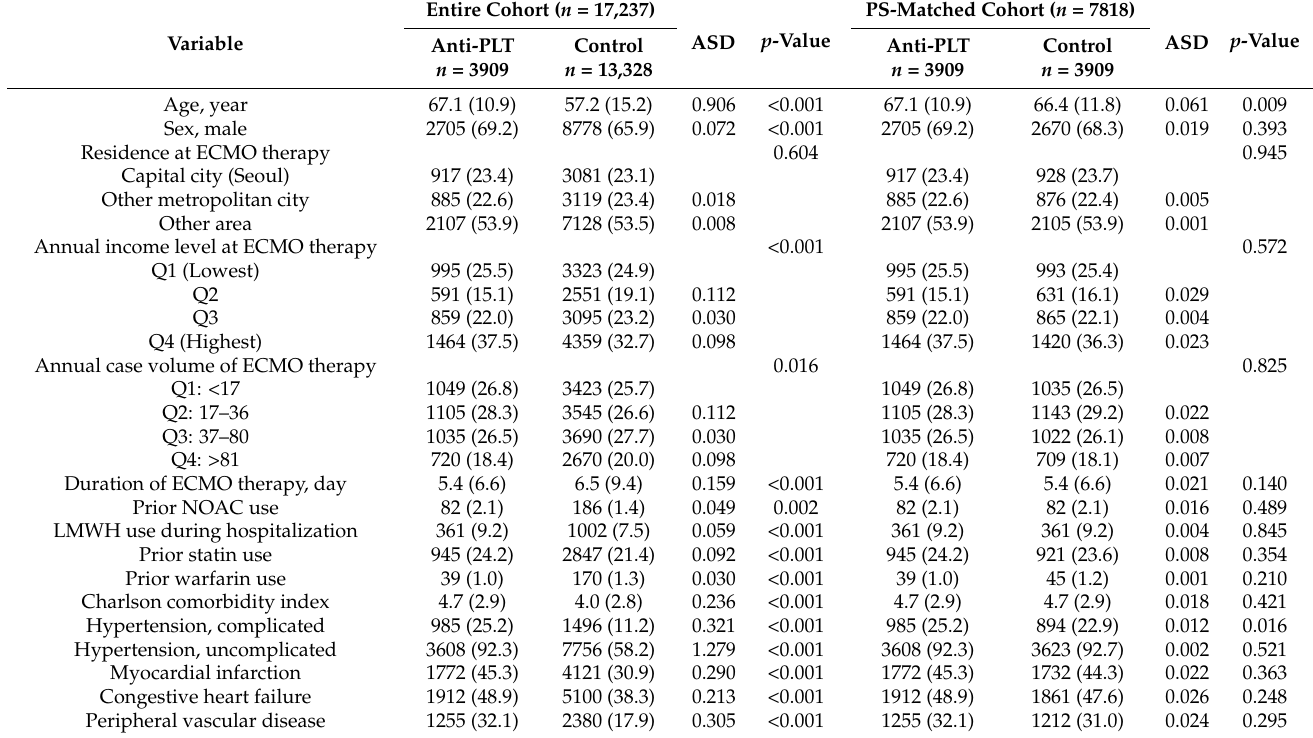
Table 4. Comparison of clinicoepidemiological characteristics between the anti-PLT and control groups before and after PS